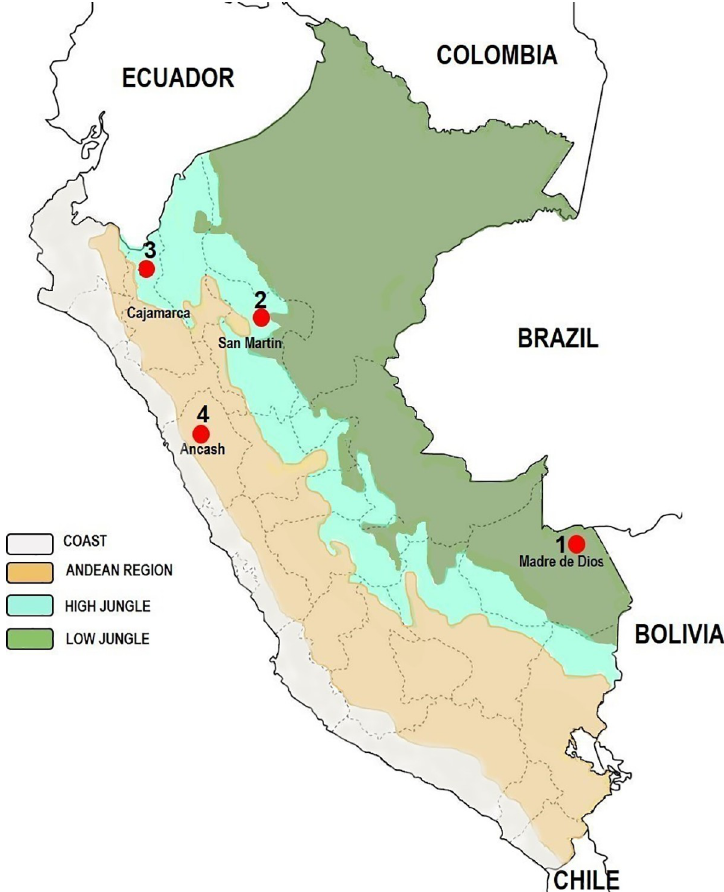
Fig 1. Study sites in three different ecological regions within Peru. The map was created using open data obtained from Wikipedia. URL: https://en.wikipedia.org/wiki/Geography_of_Peru#/media/File:Peru_veg_1970.png (public